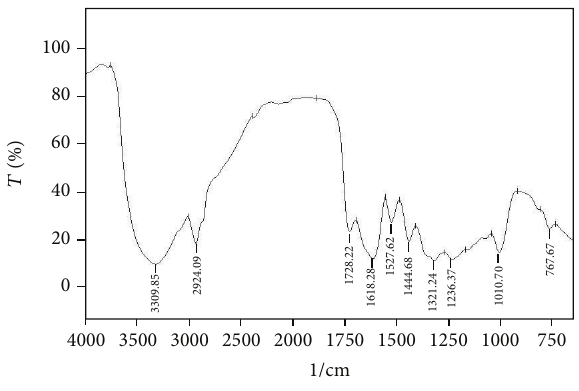
Figure 2: FT-IR spectrum of untreated GL.